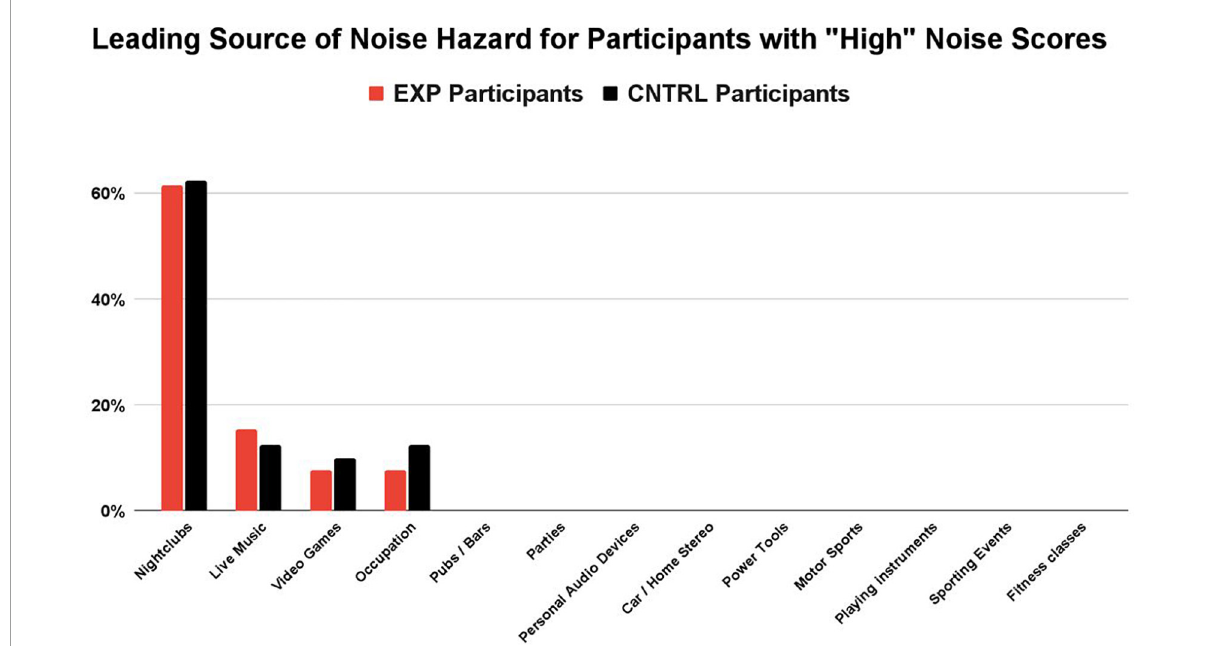
FIGURE3 For participants with “high” noise scores ( > 1.0), nightclubbing was the largest contribution of noise hazard in both groups (62% EXP, 63% CNTRL), followed by attendance at live music gigs (15% EXP, 16% CNTRL). Noise sources with the highest contribution to the overall score were determined by their sound level and the participant’s frequency of exposure. While other sources of hazardous noise may have contributed to the overall noise score (e.g., pubs/bars, parties, personal audio devices), they were never the primary noise hazard contribution in those participants with “high noise”